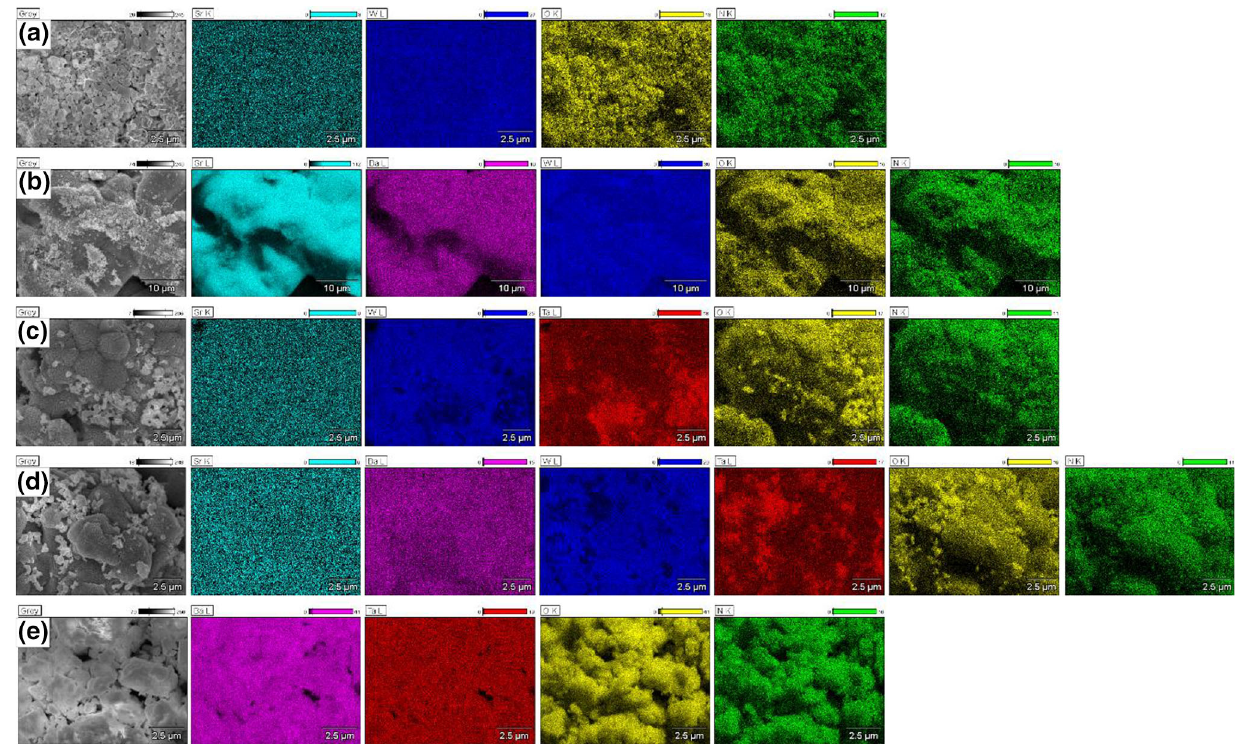
Fig. 5 EDS element mapping images of Sr 1 - x Ba x W 1 - y Ta y (O,N) 3 : ( a ) x , y = 0,0; ( b ) x , y = 0.25,0; ( c ) x , y = 0,0.25; ( d ) x , y = 0.125,0.125; and ( e )